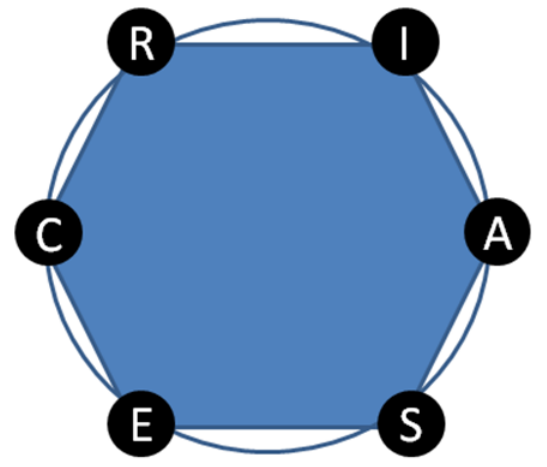
Figure 1. RIASEC hexagonal model [ 1 ] .